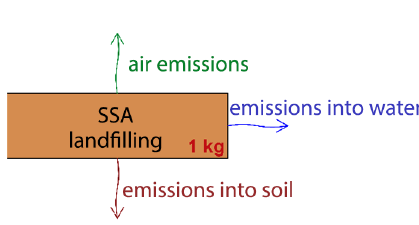
Figure 4. A simplified schematic representation of the LCA model used to assess the impact of heavy metals when SSA is deposited in landfills for non-hazardous waste